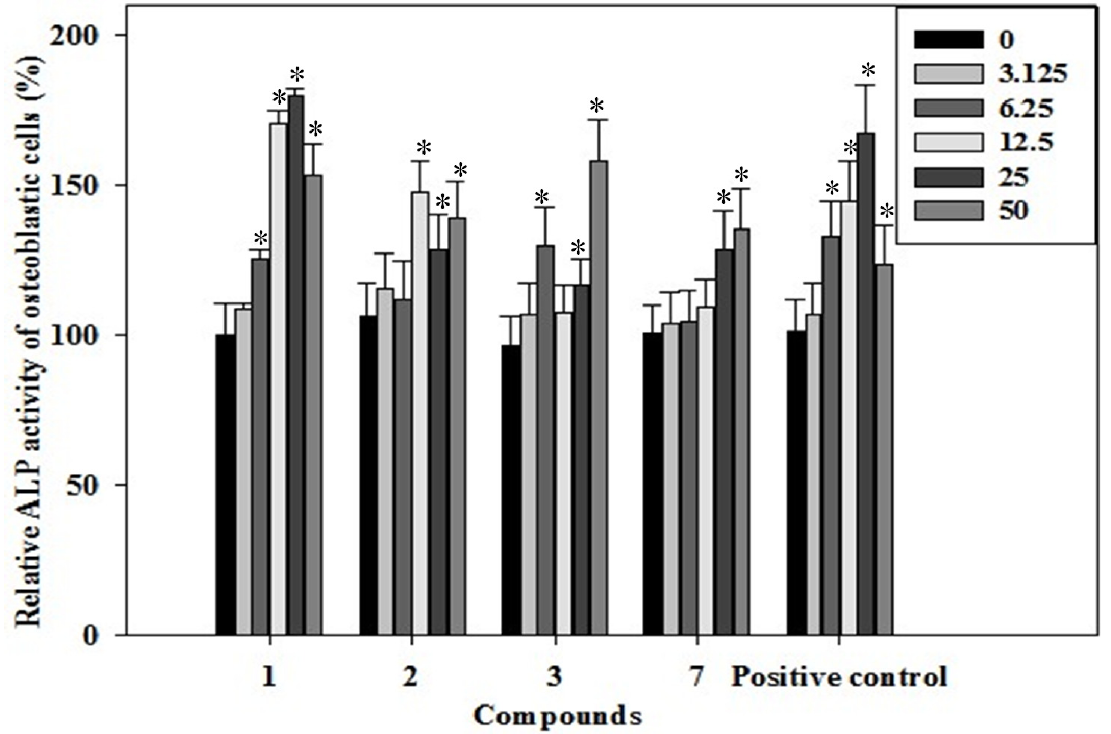
Figure 2. The effects of the phenolics ( 1 – 3 , 7 ) on ALP activity were assessed in rat osteoblast cells treated with the phenolics ( 1 – 3 , 7 ) (3.125–50 µg/mL) for 7 days.